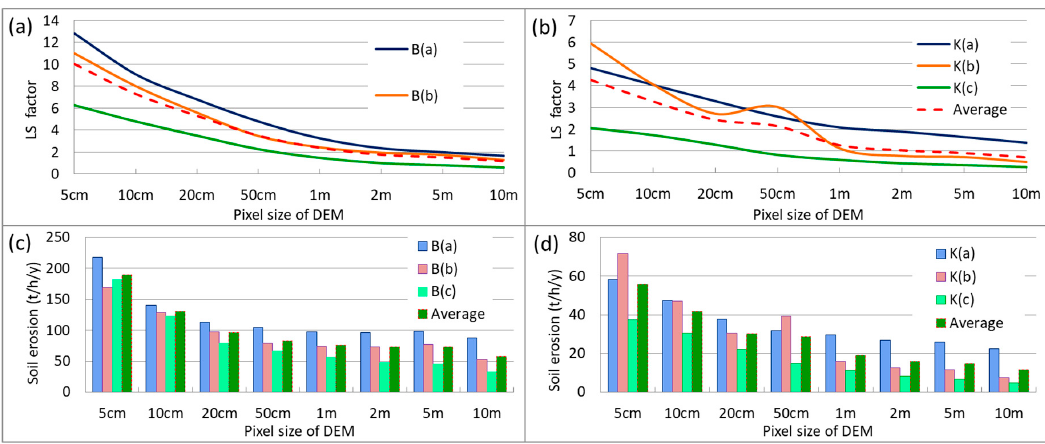
Figure 5. LS factor ( a , b ) and rate of soil erosion (t/h/y) ( c , d ) by pixel sizes of DEM.